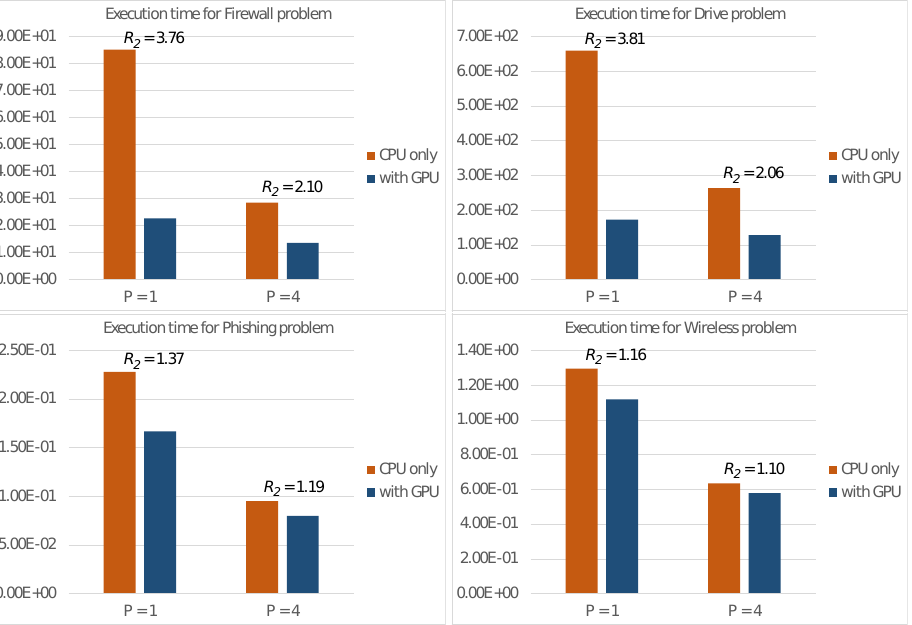
Figure 3. Execution times (in seconds) of Algorithm 1 on the Nvidia Jetson Nano board and perfor- mance gains R 2 achieved using a GPU.